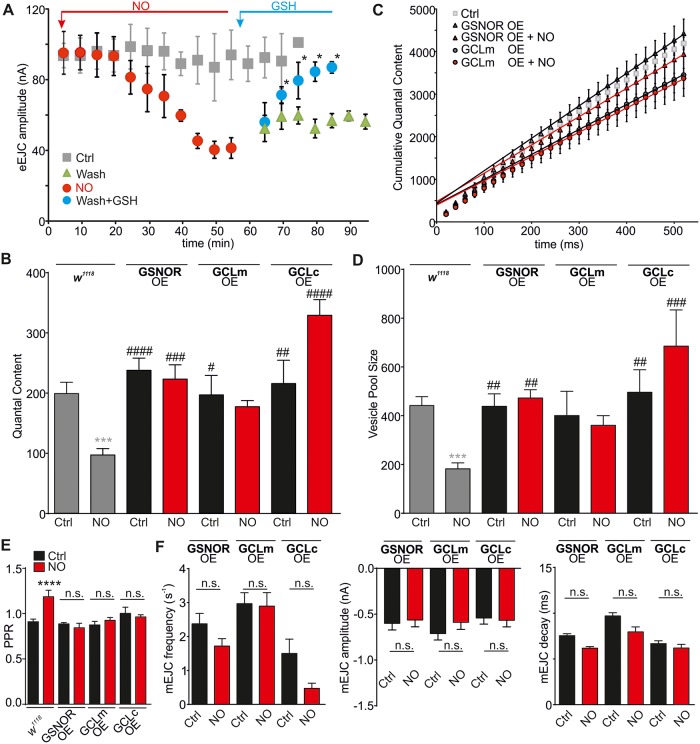
Genetic and pharmacological induction of denitrosylation reverses and prevents nitrergic effects on transmitter release and vesicle pools.(A) NO-induced suppression of evoked release (w1118 Ctrl eEJCs data in grey from Fig 1A) can be reversed after 15 min of GSH application (150 μM, blue). Wash out of NO alone shows mild nonsignificant recovery (green). (B) Mean QC for conditions indicated (OE, elav > UAS-fdh31 [GSNOR], elav > UAS-GCLm, elav > UAS-GCLc, all ± NO). NO has no effects on QC in genotypes indicated (w1118 + NO data in grey from Fig 1 for comparisons, ***p < 0.0001 w1118 + NO versus w1118), #p < 0.05, ##p < 0.01, ###p < 0.001, ####p < 0.0001 versus w1118 + NO. (C) Cumulative QC graphs for genotypes indicated (±NO) with linear regression to the last 200 ms, Ctrl in grey taken from Fig 2 for comparison. (D) Mean RRP sizes, NO has no effects on vesicle pool size in tested genotypes (w1118 data in grey from Fig 1, w1118 + NO versus w1118: ***p < 0.0001), ##p < 0.01, ###p < 0.01, ####p < 0.01 versus w1118 + NO. (E) PPR at 20 ms ISI for indicated conditions, ****p < 0.0001 versus Ctrl. (F) mEJCs analysis: left, mean mEJC amplitudes (±NO), middle, mean mEJC frequencies (±NO), right, mean mEJC decay kinetics for genotypes indicated (±NO). OE of GSNOR, GCLm, or GCLc prevents NO effects on the frequency of mEJCs. The raw data can be found in S4 Data. Data denote mean ± SEM for all data comparisons. ANOVA with post hoc Tukey-Kramer. Ctrl, control; eEJC, evoked EJC; EJC, excitatory junction current; fdh, formaldehyde dehydrogenase; GCLc, glutamate-cysteine ligase catalytic subunit C; GCLm, glutamate-cysteine ligase catalytic subunit M; GSH, glutathione; GSNOR, S-nitrosoglutathione reductase; ISI, interspike interval; mEJC, miniature EJC; NO, nitric oxide; n.s., nonsignificant; OE, overexpression; PPR, paired pulse ratio; QC, quantal content; RRP, readily releasable pool.